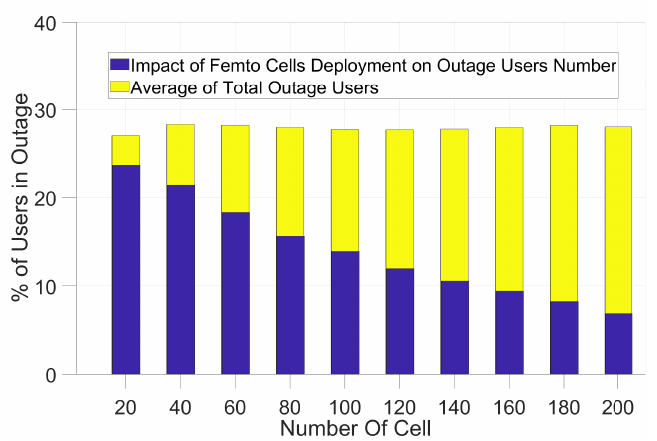
Figure 5. Simulation of macro-cell in the presence of Femto cells with Path-loss model—Equation (2).